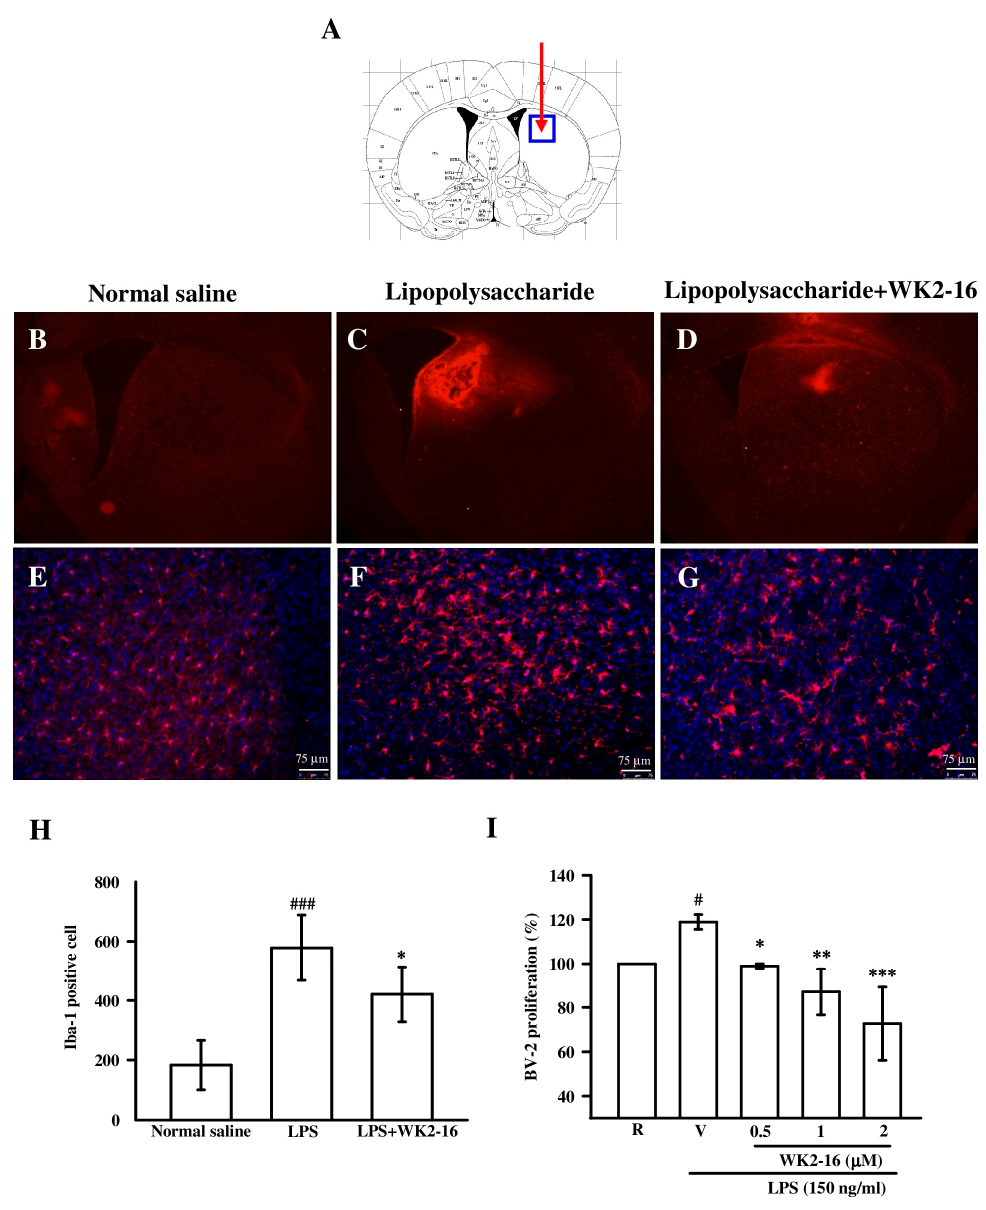
Figure 3. WK2-16 suppressed LPS-induced microglial activation and proliferation. ( A ) Schematic illustration of the site of stereotaxic injection in the caudate/putamen region (red arrow). ( B , C , D ) Brain sections (50 µ m thick) were prepared eight hours after intrastriatal normal saline or LPS (4 µ g/3 µ L) injection in the presence or absence of WK2-16 (30 mg/kg). Microglia were visualized using fluorescent immunostaining with an anti-Iba-1 antibody (red). ( E , F , G ) Higher magnification fluorescence microscopy of the rectangular area in Figure 3A. Figure 3E,F,G are magnified from Figure 3B, C, and D in the striatum, respectively. Iba-1 immunostaining was counterstained with DAPI (blue). Scale bar = 75 µ m. ( H ) Quantification of cells positive for Iba-1. The data are presented as the means ± SD from 4 animals. (I) BV-2 microglia were pretreated with WK2-16 at varying concentrations followed by LPS (150 ng/mL) incubation for 48 h. The relative cell proliferation was determined using the SRB assay in vitro ( n = 3). R: resting; V: vehicle (DMSO). # p < 0.01, ### p < 0.001 compared to the normal saline-injected group in vivo or resting group in vitro ; * p < 0.05, ** p < 0.01, *** p < 0.001 compared to the LPS-treated group treated with vehicle in vivo and in